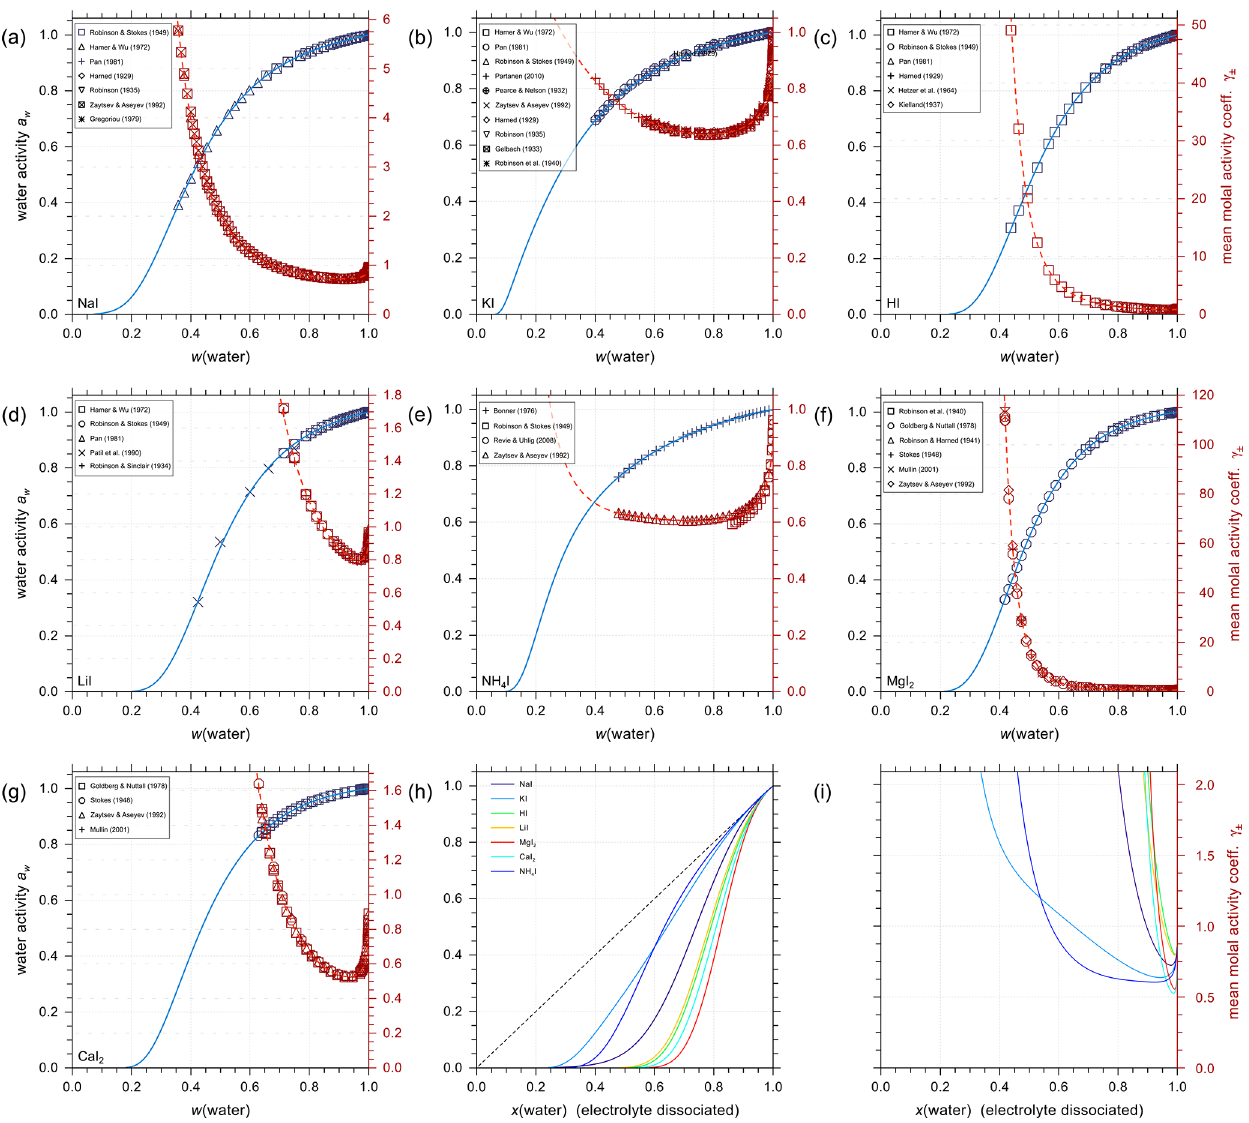
Figure 2. Water activities and mean molal activity coefficients of the electrolytes in binary aqueous iodide solutions near 298.15K. The symbols represent the experimental data and the solid curves show the AIOMFAC predictions. The panels (a) to (g) show as x axis the mass fraction of water, w (water), while panels (h) and (i) show the mixture composition in terms of x (water), the mole fraction of water defined with respect to dissociated electrolytes. The left y axis (blue curves, symbols) indicates water activity, and the right y axis (red curves, symbols) indicates the mean molal activity coefficients. Electrolytes: (a) NaI, (b) KI, (c) HI, (d) LiI, (e) NH 4 I, (f) MgI 2 , and (g) CaI 2 . (h) AIOMFAC-calculated water activity curves of all the iodide electrolytes implemented; the dashed black line indicates the water activity of an ideal mixture. (i) Corresponding mean molal activity coefficient